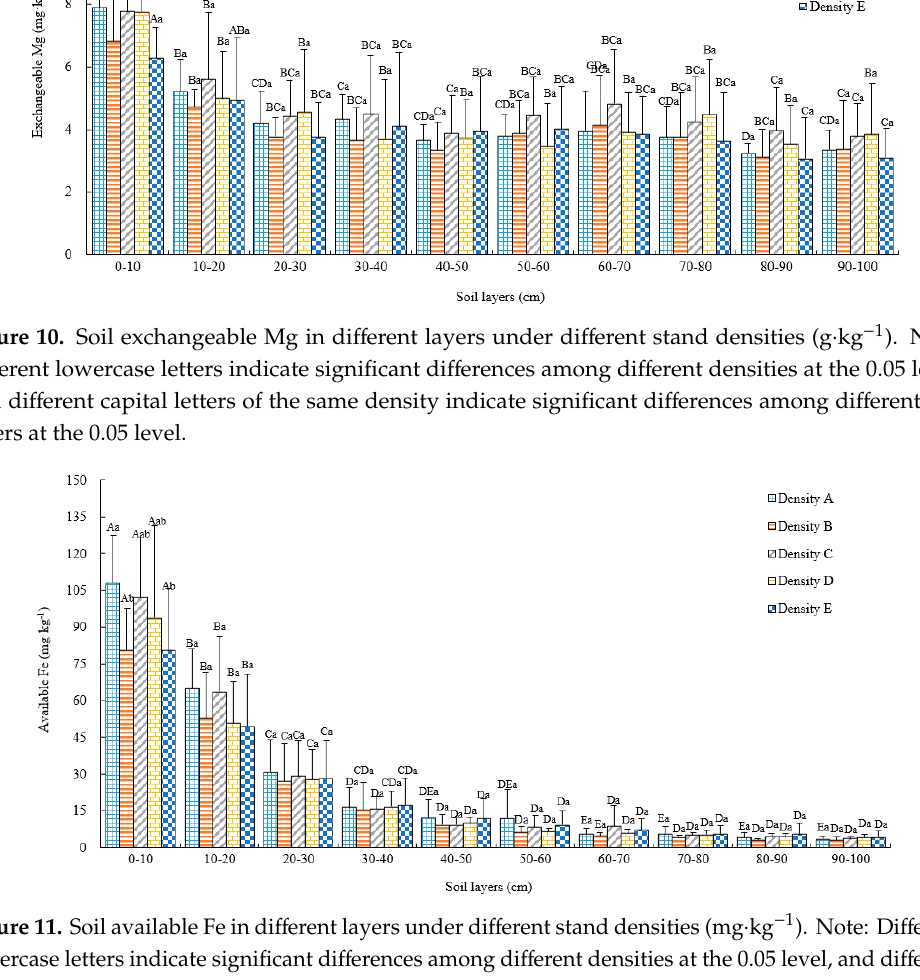
Figure 10. Soil exchangeable Mg in different layers under different stand densities (g·kg − 1 ). Note: different lowercase letters indicate significant differences among different densities at the 0.05 level, and different capital letters of the same density indicate significant differences among different soil layers at the 0.05 level.